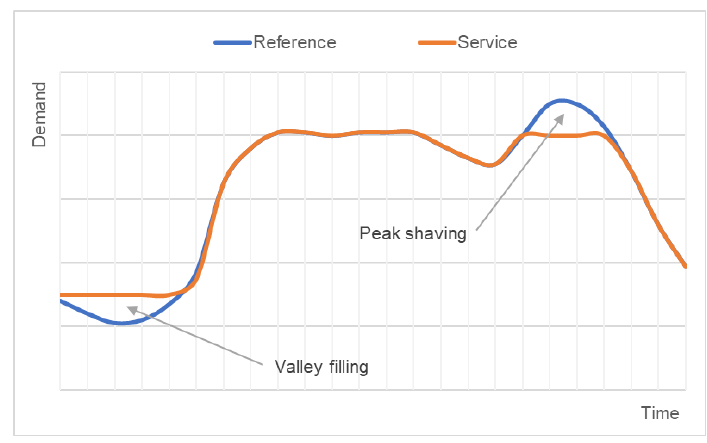
Figure 2. Peak shaving and valley filling services.